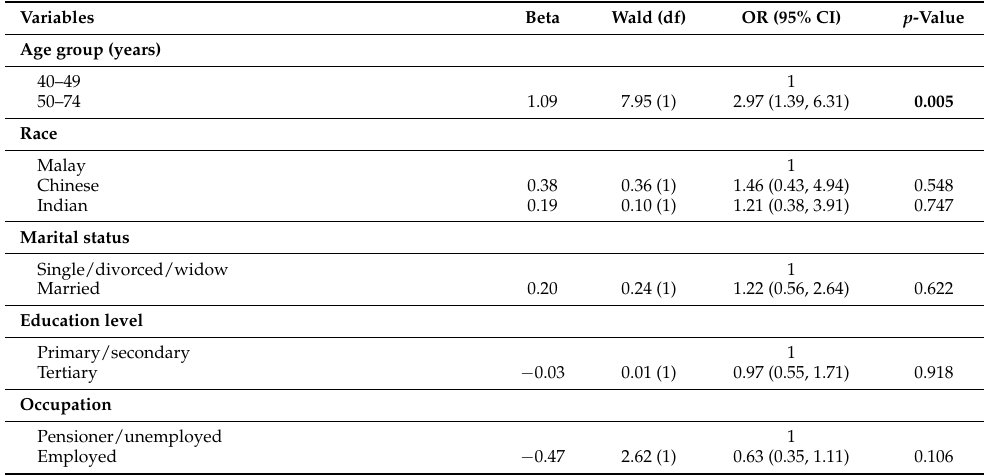
Table 4. Association of sociodemographic, clinical factors, knowledge and health beliefs with screen- ing mammogram